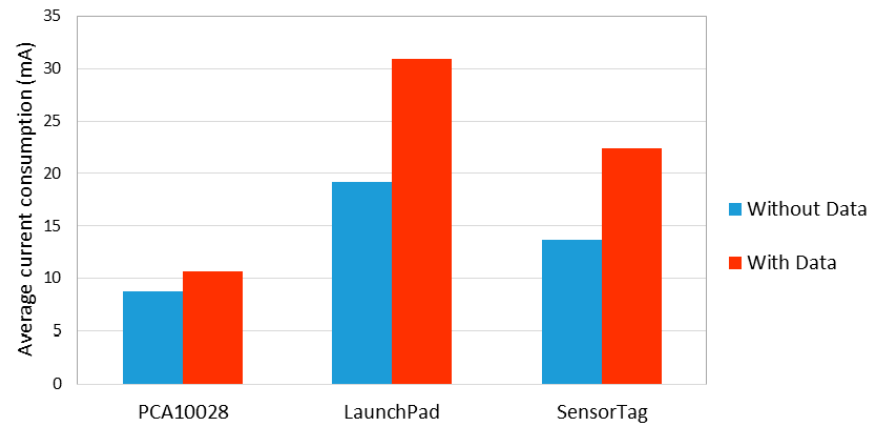
Figure 14. Average current consumption of active parts in connection events with and without data packets, for different device hardware platforms.